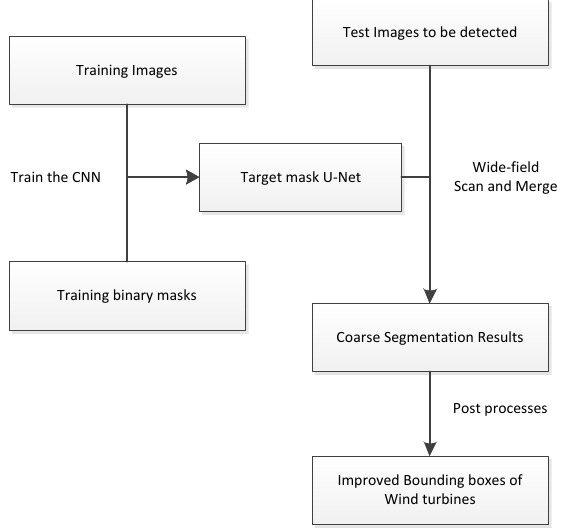
Figure 1. Proposed method for wind turbine detection